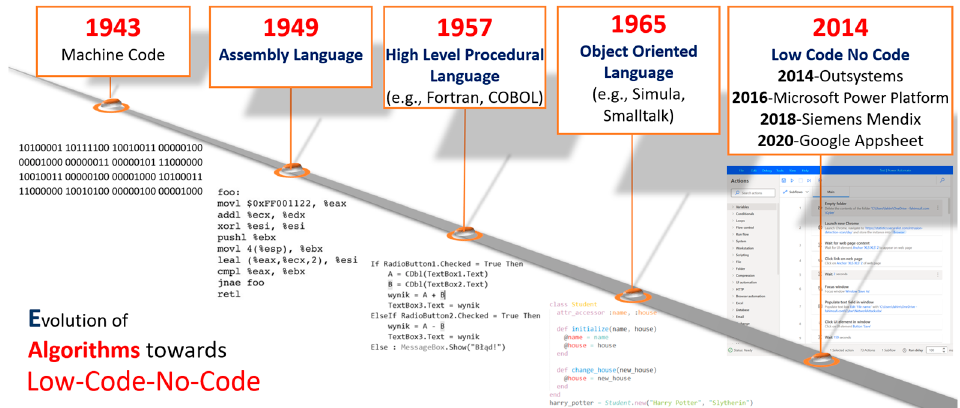
Figure 1. Evolution of algorithms from machine code to low ‐ code ‐ no ‐ code.